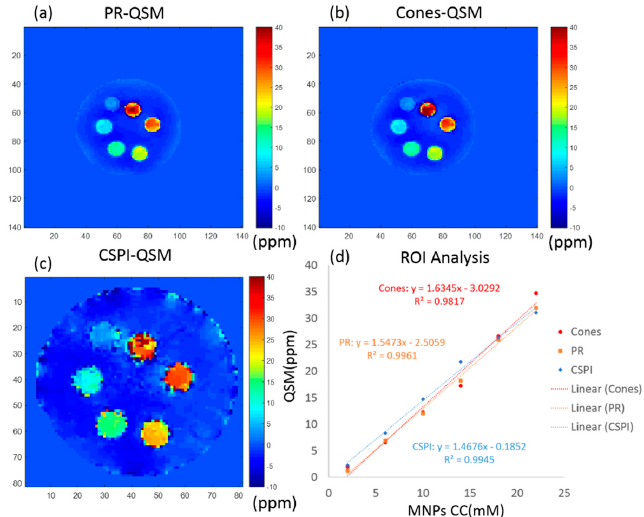
Figure 3. UTE-QSM) results of an iron phantom obtained with three different sequences: ( a ) 3D UTE-PR (PRQSM), ( b ) 3D UTE-Cones (Cones-QSM), and ( c ) 3D UTE CSPI (CSPI-QSM). Region of